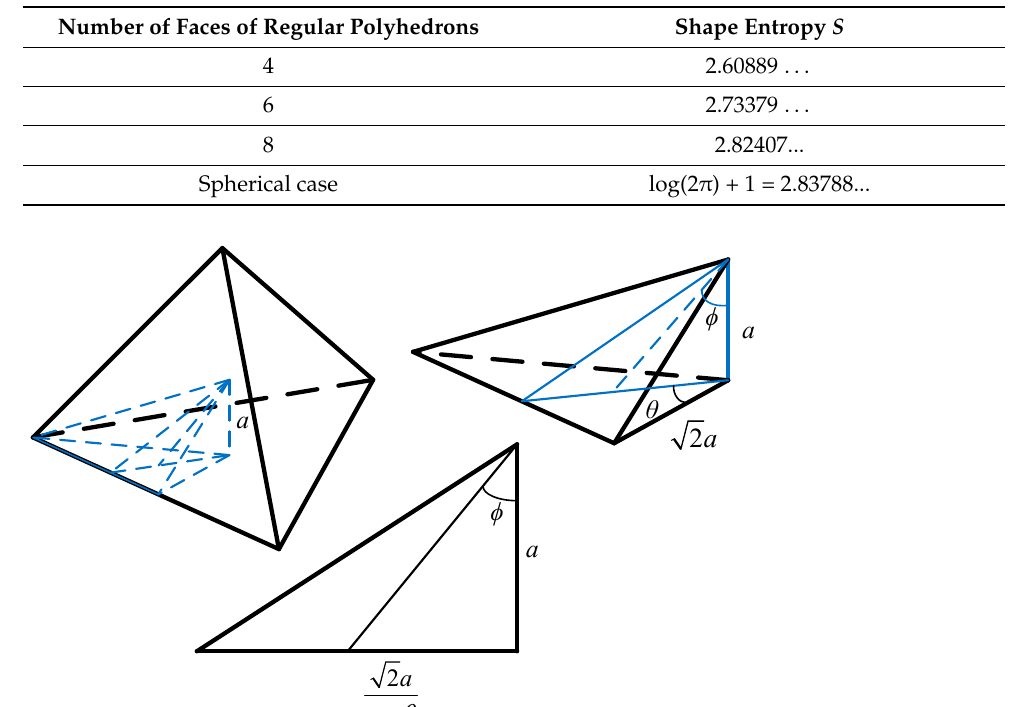
Table 3. The shape entropies of regular polyhedrons.